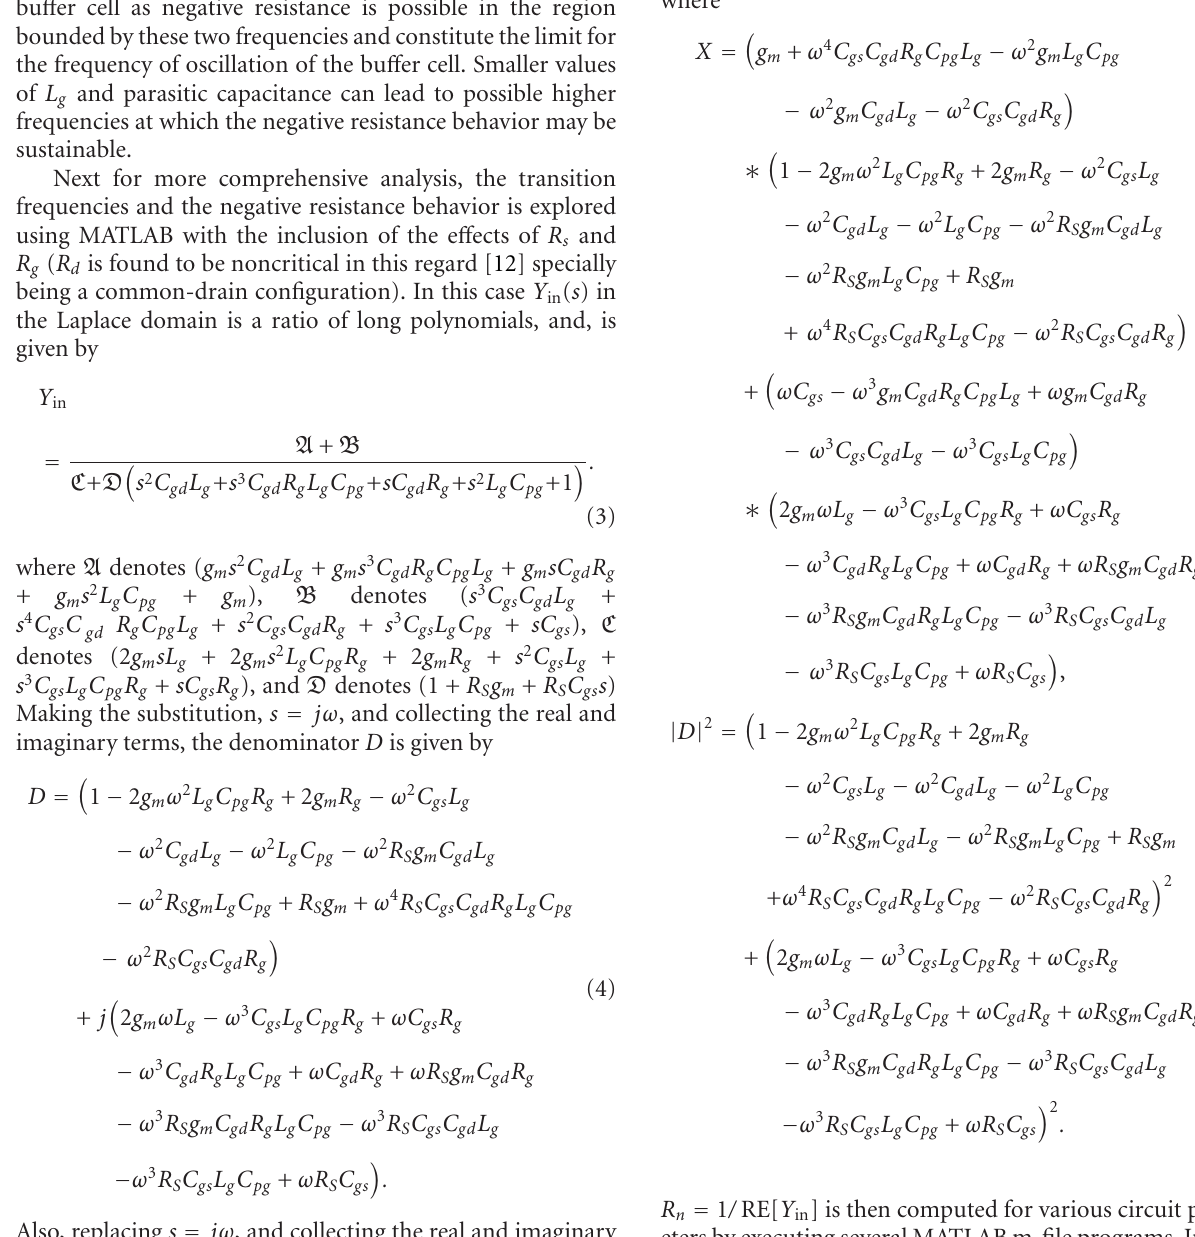
R s = 12 . 7 Ω for a 130 nm IBM CMOS process